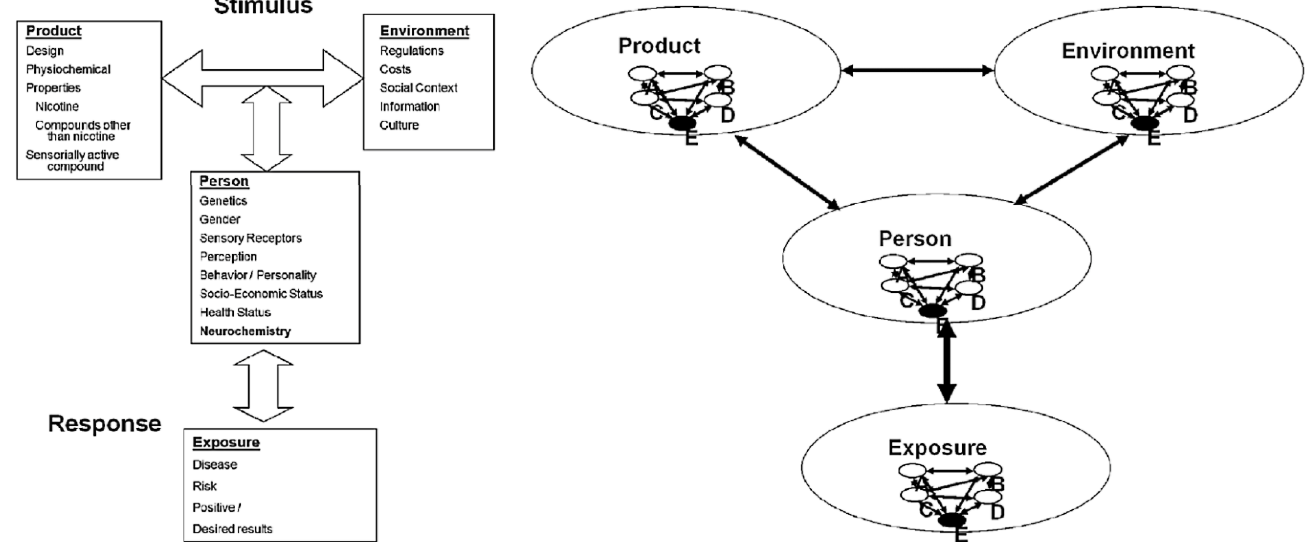
Fig 2. Philip Morris’s 2005 “Determinants of Exposure Consensus Group” diagrams their addiction model in two ways [91]. Left: Stimuli interact to determine response, which then interacts with stimuli. Product: design, physiochemical properties (i.e., nicotine, compounds other than nicotine), and sensorially active compounds. Environment: regulations, costs, social context, information, and culture. Person: genetics, gender, sensory receptors, perception, behavior/ personality, socioeconomic status, health status, and neurochemistry. Exposure: disease, risk, and positive/desired results. Right: within each stimulus/response, A, B, C, D, and E interact with each other, affecting the larger component. A, Sensation; B, Perception; C, Genetics; D, Behavior; E,